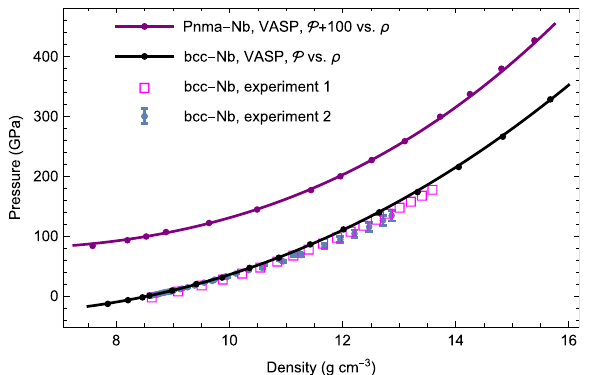
Fig. 10 The zero temperature equations of state of two solid phases of niobium. Black curve: VASP results on body-centered cubic bcc-Nb vs the experimental results from ref. 45 (experiment 1, empty squares) and ref. 47 (experiment 2, bullets). The error bars of experiment 1 are smaller than the size of the symbol. Magenta curve: VASP results on orthorhombic Pnma - Nb. The Pnma -Nb curve is shifted up by 100 GPa for